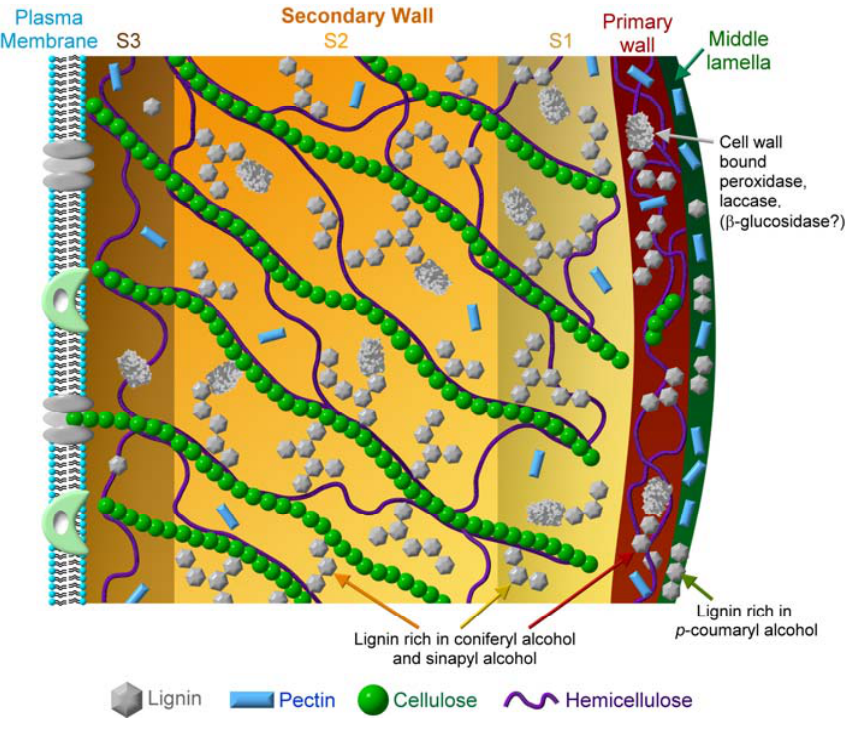
Figure 8. Illustration of a plant cell wall. The various features of the plant cell wall described above are shown including the relative thickness of the various layers and the relative abundance and specific localization of the various cell wall components, such as pectin, cellulose, hemicellulose, lignin and protein. The relative contributions of the three major monlignols to the lignin in the various layers are also indicated. The cell wall-bound enzymes might participate in the various steps of